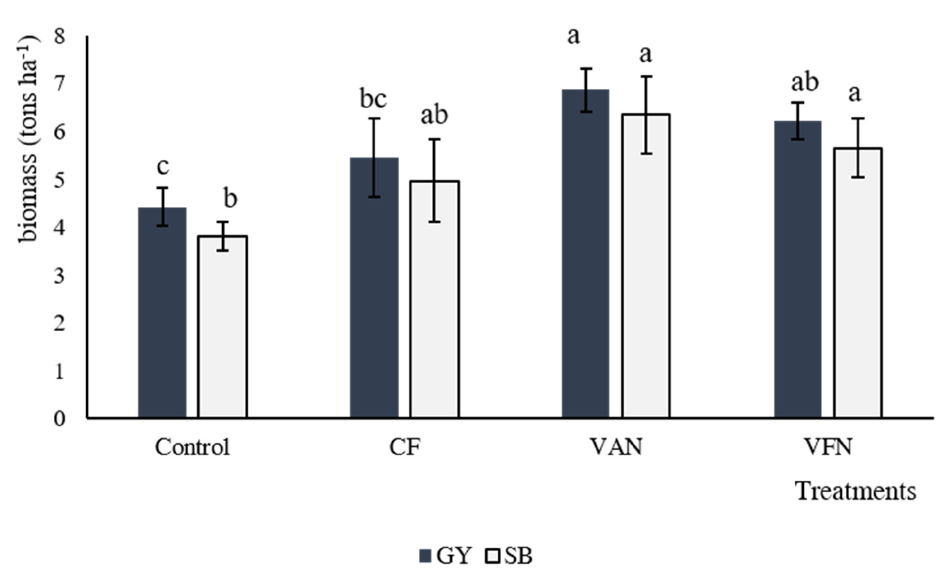
Figure 5. Effect of different N treatments on grain yield (GY) and straw biomass (SB) (t ha − 1 ) of barley cultivated during the season 2018/2019. Bars with the same letter are not significantly different ( p > 0.05). Control (0 kg N ha − 1 ); CF (conventional fertilization—150 kg N ha − 1 ); VAN (variable N appli-